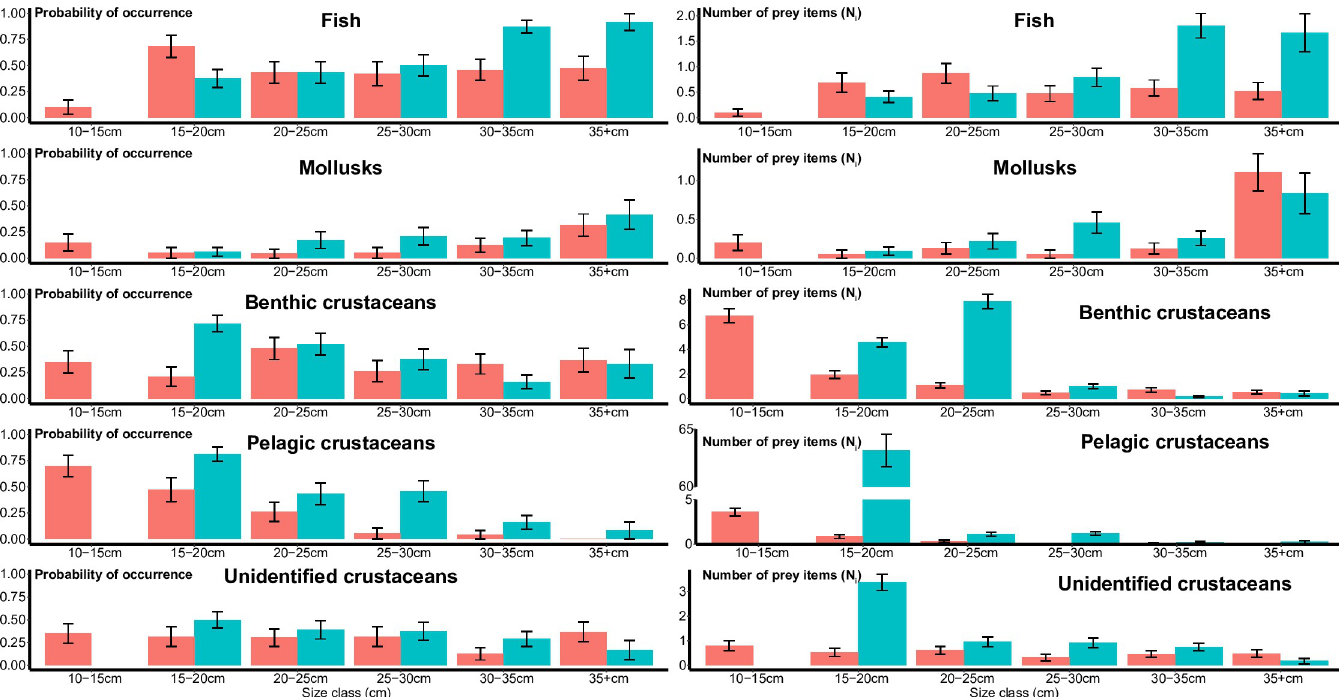
Fig 3. Predicted values from GLM for average probability of prey occurrences (left) and number of prey items (N i ) in an individual stomach (right) and for both seasons (autumn in red and winter in blue). Errors bars correspond to standard errors. For graphical purposes, the vertical axis of the plot presenting abundance of pelagic crustaceans was cut between 5 and